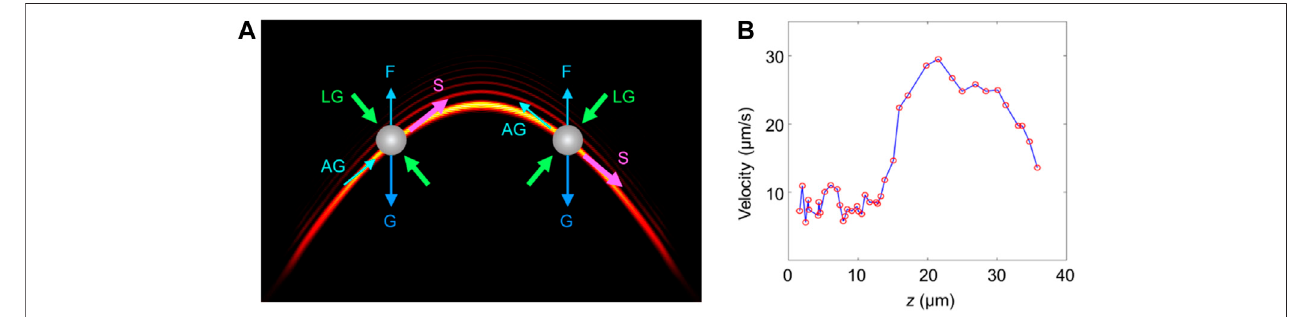
FIGURE4| Quanti fi cationoftheparticlemotion. (A) Schematicdiagramoftheprimaryforcesactingontheparticle.G:gravity,F: fl oatage,LG:lateralgradientforce, AG: axial gradient force, S: scattering force; (B) velocities of the particle at different axial